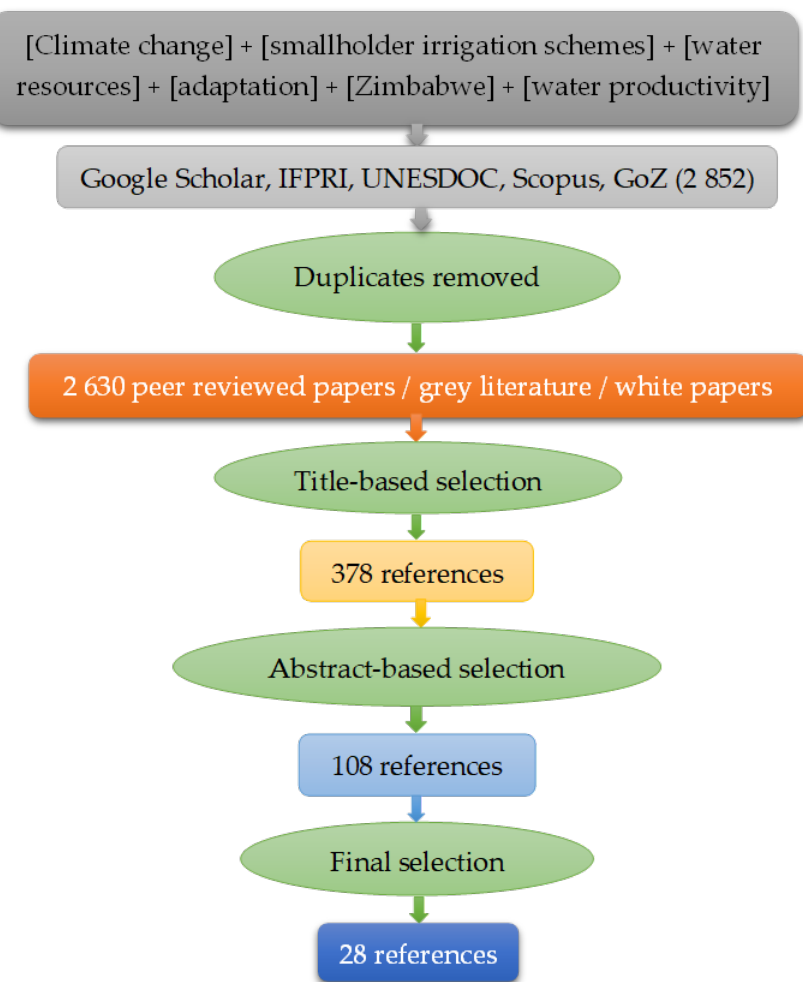
Figure 1. Schematic flowchart of the review process. Table 1. Mann–Kendall trend tests for precipitation and temperature in